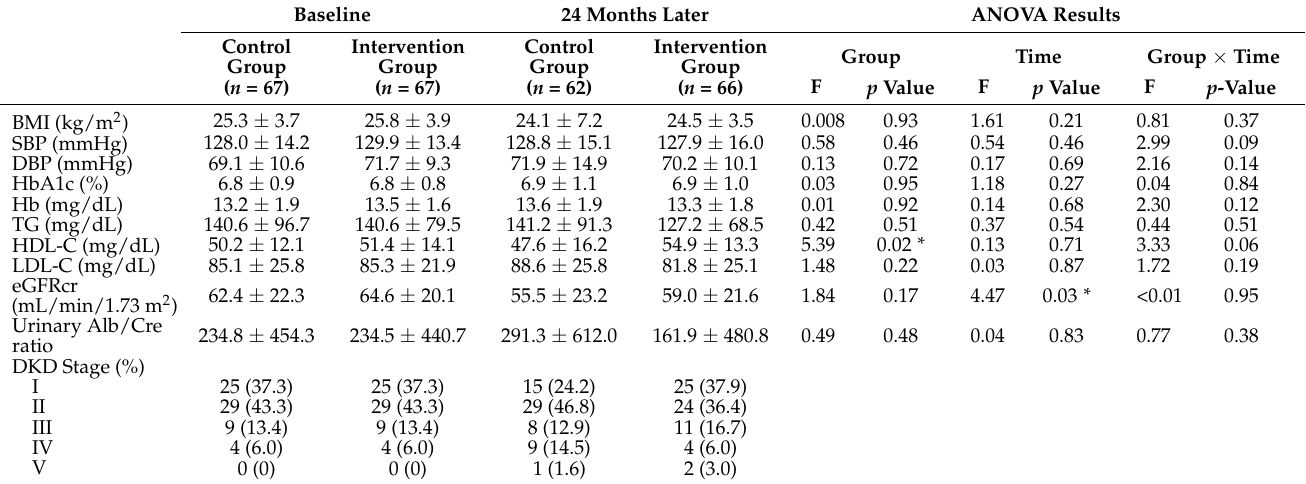
Table 4. Clinical characteristics between the two groups at the start and end of the observation.